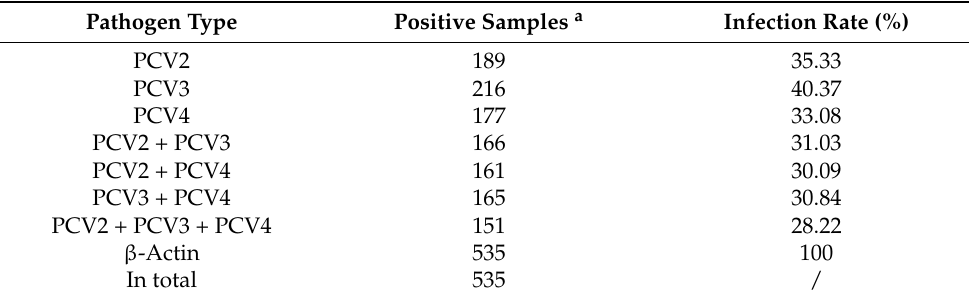
Table 5. Analysis of clinical samples using multiplex TaqMan